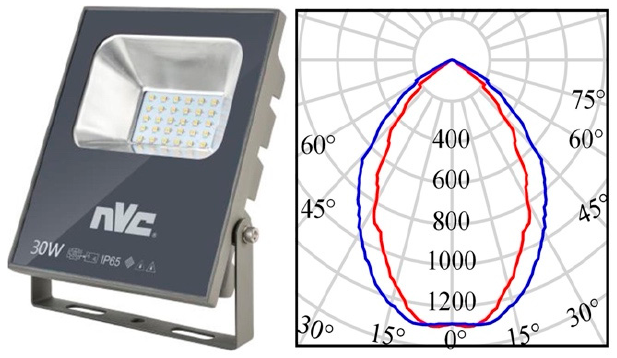
Figure 2. Photo of NVC LED luminaires and light distribution curve.